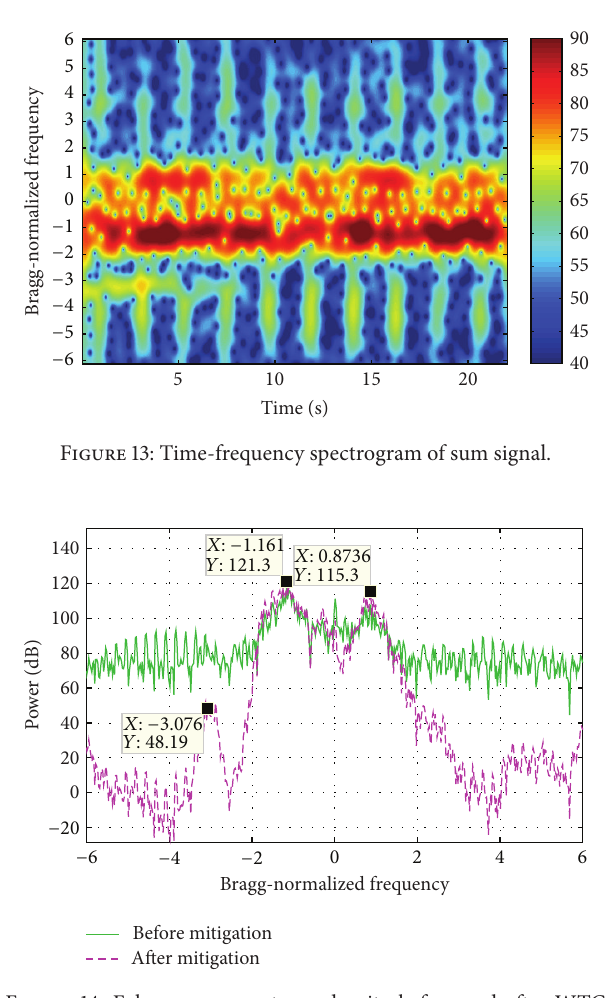
Figure 14: Echo power spectrum density before and after WTC mitigation.